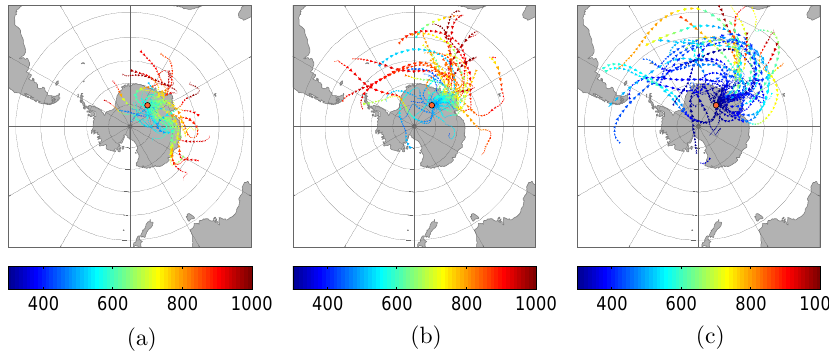
Figure 11. Horizontal course of the available trajectories for days with either measured or modelled precipitation events with arrival times at 00:00 and 12:00UTC arriving at (a) 600hPa, (b) 500hPa and (c) 300hPa. The colours show the pressure level in hPa. The red dot marks the location of Dome F.